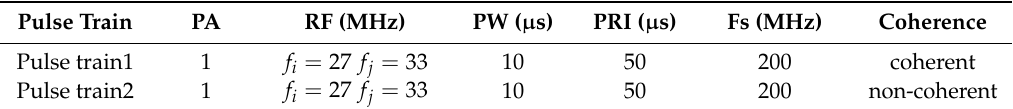
Table 3. Parameters of frequency-agile signals (FAS).